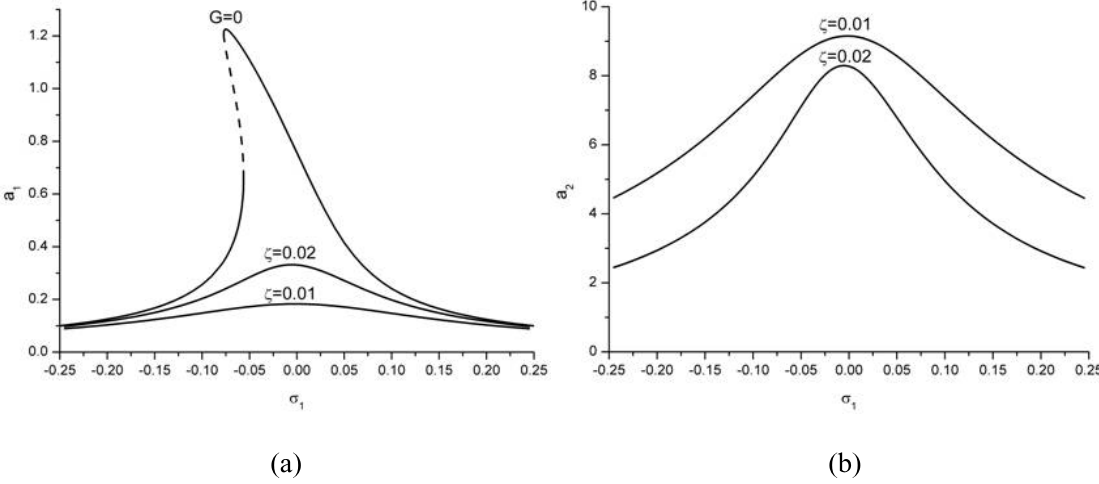
Fig. 5. Effect of varying the absorber’s damping on the frequency-response curves of (a) the plant and (b) the absorber when f = 0 . 025 , G = 0 . 005 and ν 2 = 0